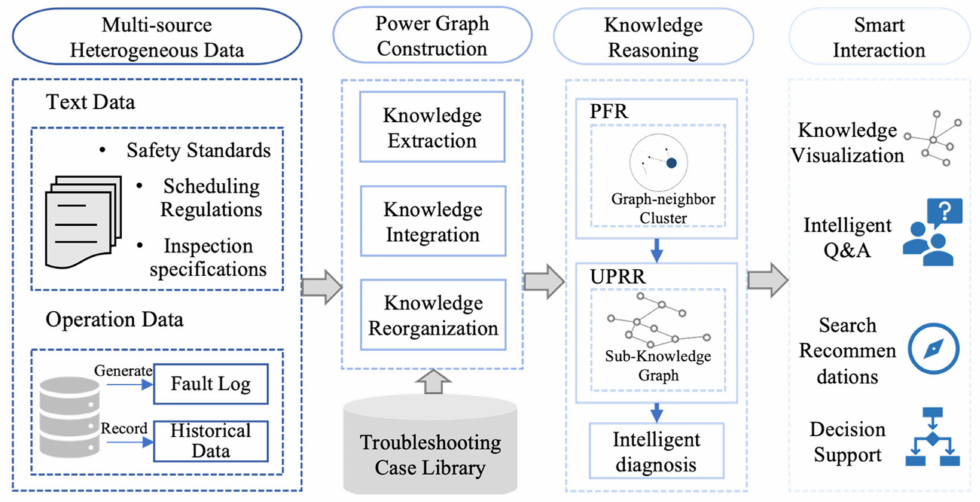
Figure 1. The architecture of our model: